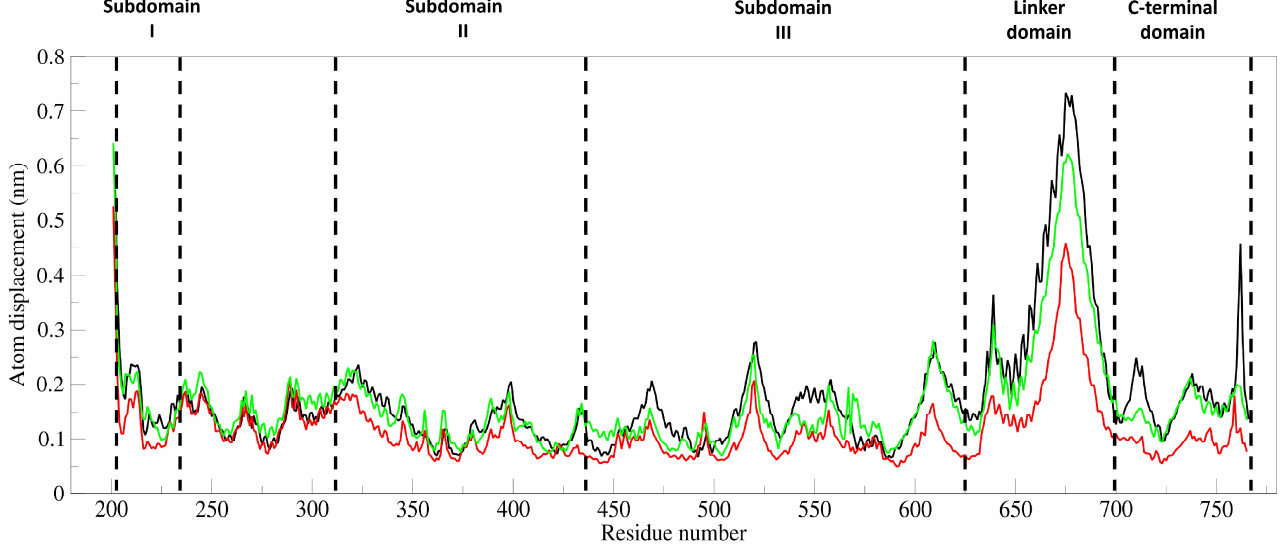
Figure 9. Atomic displacement. Atomic displacement calculated for each of the 565 C-alpha atoms of hTop1, computed along the direction of the first eigenvector for the three MD trajectories. The black line indicates the unbound hTop1-DNA complex, while the red and green lines indicate the complex with DM in the catalytic site or intercalated within the DNA bases, respectively. Dotted lines separate the DNA region from the different hTop1 domains, as indicated by the labels.